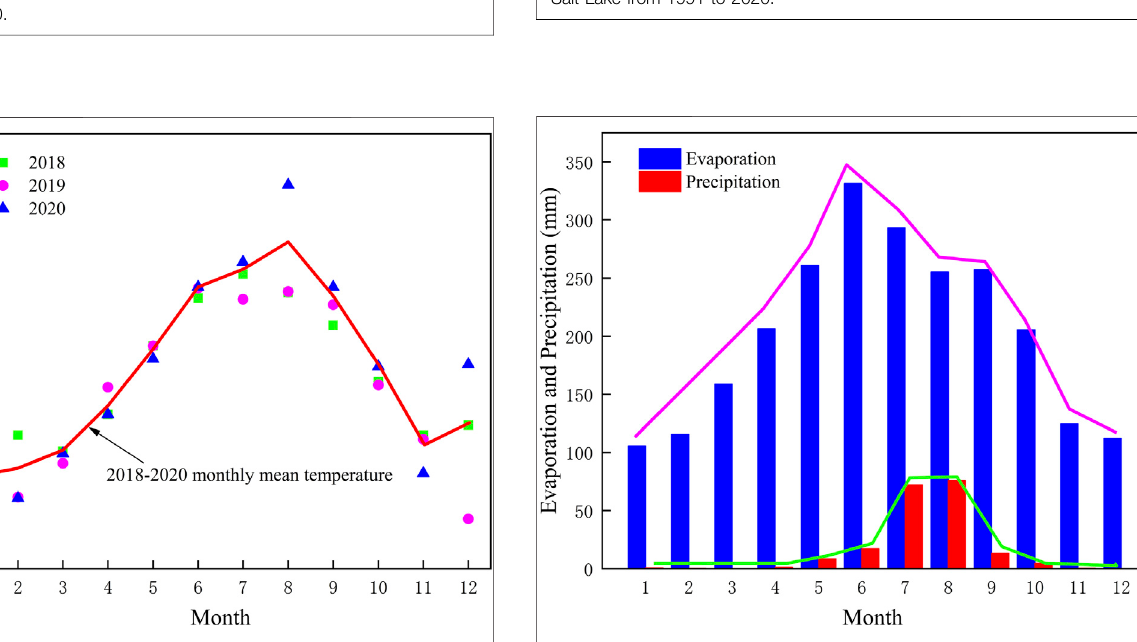
FIGURE6| ChangesofmonthlyprecipitationandevaporationinZabuye Salt Lake from 2018 to 2020.